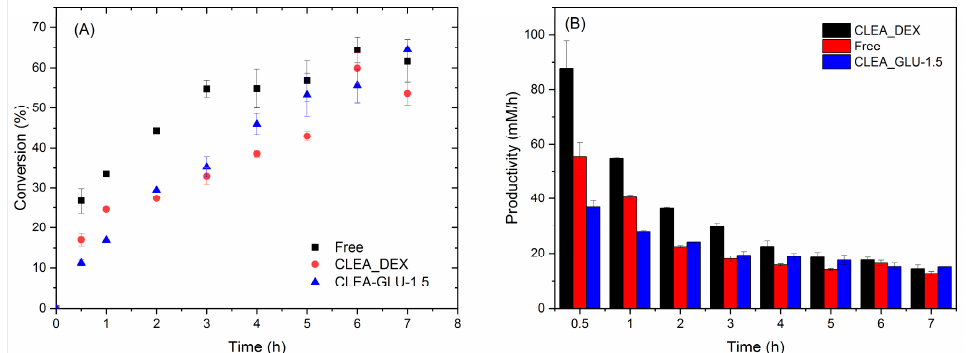
Figure 3. Enzymatic production of D-galactose and D-glucose catalysed by free and immobilised β -galactosidase from Aspergillus oryzae (mCLEA-GLU-1.5, mCLEA-DEX) in potassium phosphate buffer (pH 6.6), with 0.1 mM MnCl 2 as a cofactor, at 37 °C. Substrate conversion ( A ) and Productivity ( B ) are represented as a function of the reaction time. The initial concentration of lactose was 164 mM. The reaction was carried out in a final volume of 5 mL using 0.3 g of mCLEA.